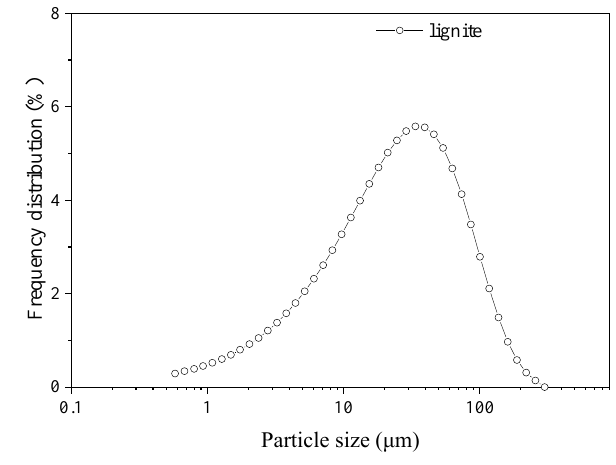
Figure 1. Particle size distribution of lignite. Table 1. Proximate and ultimate analysis of lignite.